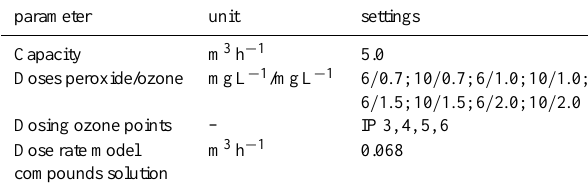
Table 2. Settings of the standard